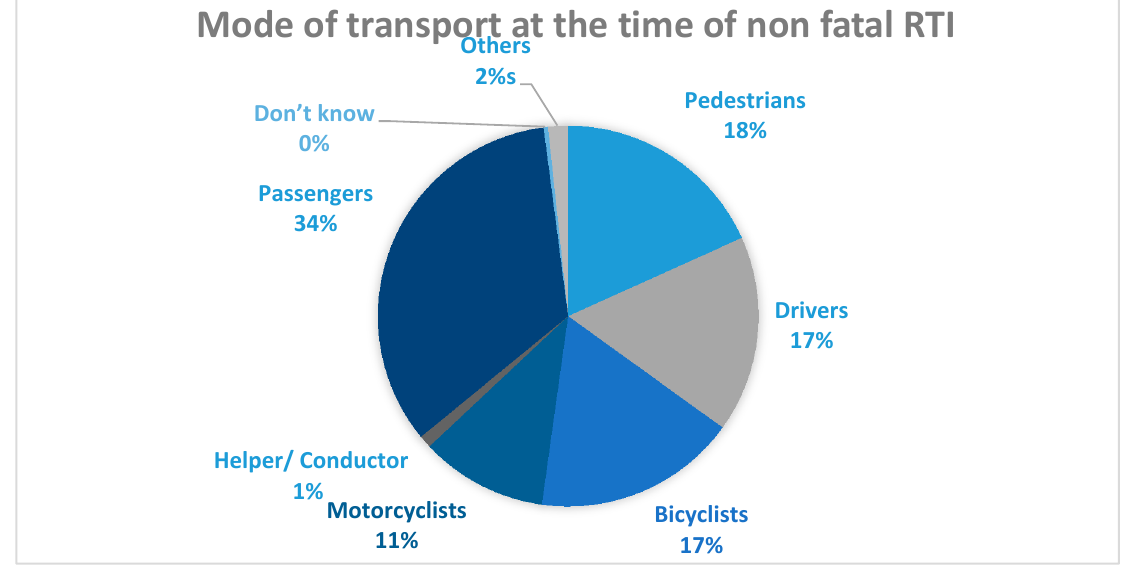
Figure 1. Mode of transport at the time of non-fatal RTI.